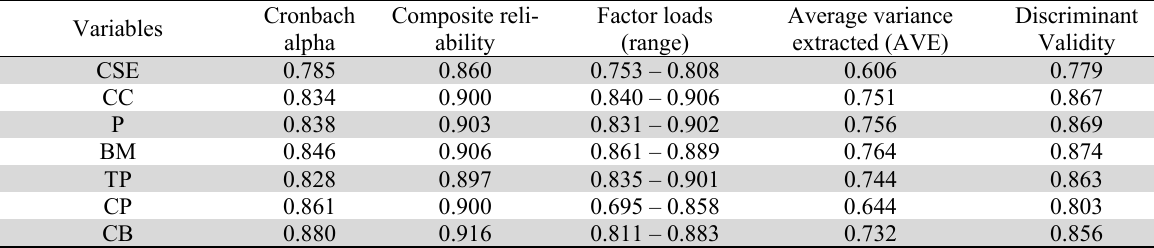
Results of the model measurement